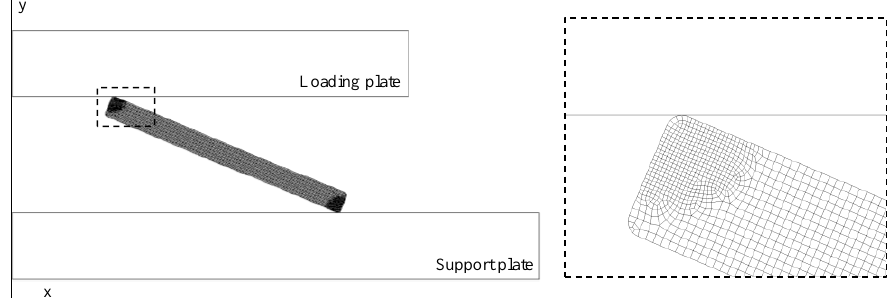
Figure 3. 2D axisymmetric model of the Belleville spring discretized, showing mesh detail. Boundary conditions restrict all degrees of freedom of the nodes on the support plate while applying a prescribed displacement to the loading plate. Because lubricating oil is used in the experiments, a low friction contact is defined with a coefficient of 0.11 [28] between the upper and lower rounded corners (radius of 0.1 mm) of the NiTi Belleville spring and the loading and support plates (structural steel), respectively; with symmetric behavior, augmented Lagrange formulation, and an on-Gauss point detection method. Thermal effects are disregarded in this model.